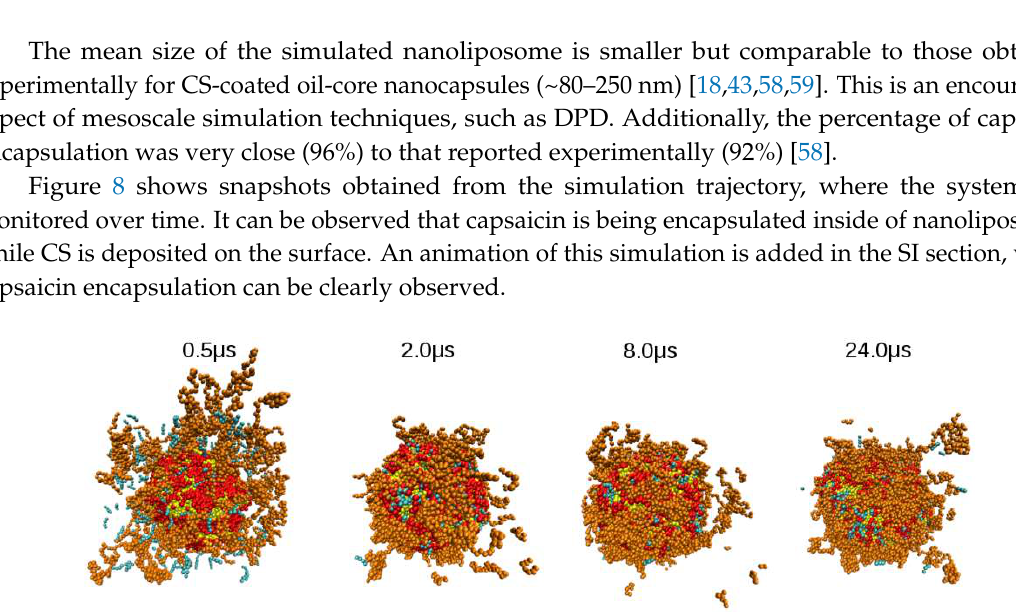
Figure 8. Snapshots of adsorption of CS on the nanoliposome at various times during simulation.